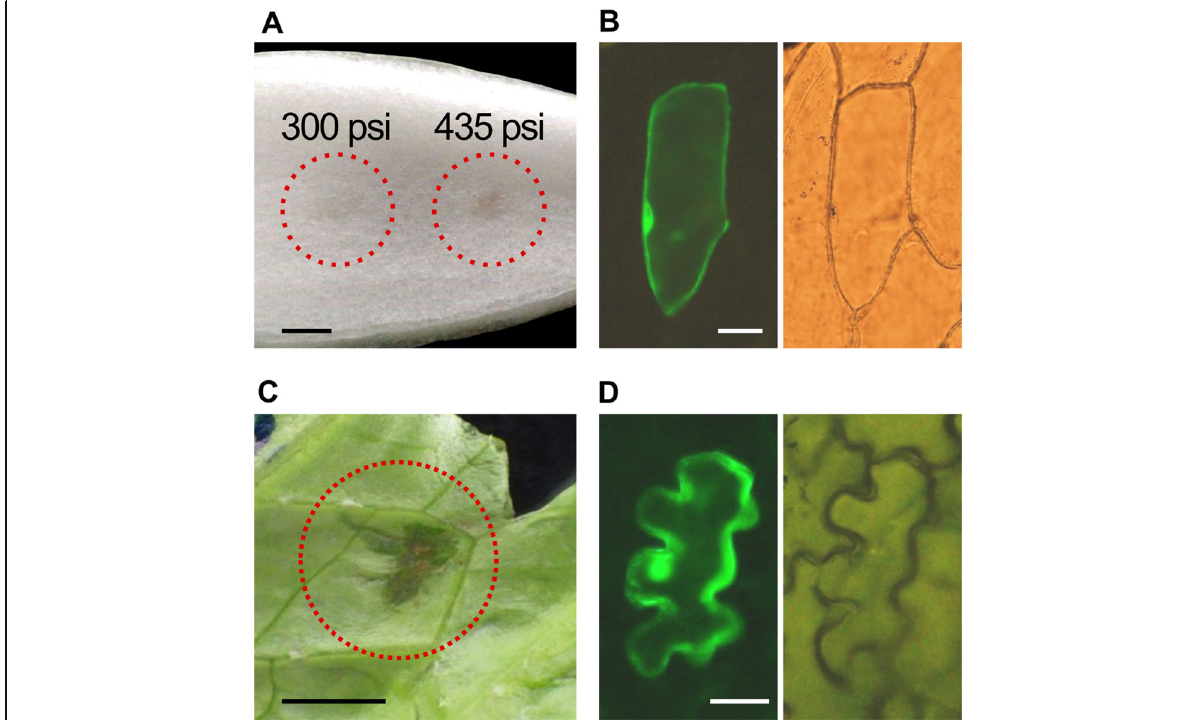
Fig. 2 Transfer of an exogenous gene into cells via TSGAMAP. a DNA-coated gold particles shot at an onion leaf with TSGAMAP. The circles indicate regions with the gold particles. Pressures used to shoot the particles ( “ 300 psi ” and “ 435 psi ” ) are also indicated. The picture was taken after the gold particles on the leaf surface were wiped. Scale bar = 5 mm. b GFP signals detected in an onion epidermal cell (left panel). A bright- field image for the same cell (right) is presented as a control. Scale bar = 50 μ m. c A lettuce leaf shot with TSGAMAP. The pressure used was 175 psi. The circle indicates the shot region. Scale bar = 5 mm. d GFP signals detected in a lettuce epidermal cell (left panel). A bright-field image for the same cell (right) is presented as a control. Scale bar = 25 μ